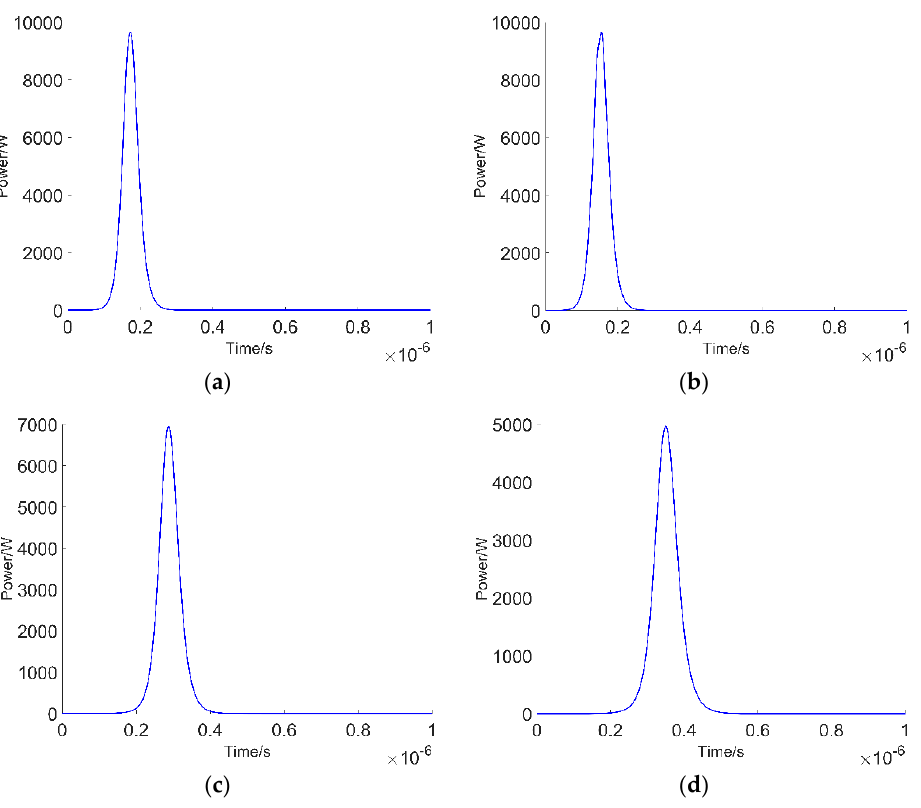
Figure 10. Numerically calculated dependence of the output power on time for a 2 (m) long fiber with the facet reflectivity for signal wave at z = L switched between 0.04 and 0.2 and pump power of 8 (W): ( a ) For T tr = 100 (ns); ( b ) For T tr = 50 (ns); ( c ) For T tr = 400 (ns); ( d ) For T tr = 600 (ns).